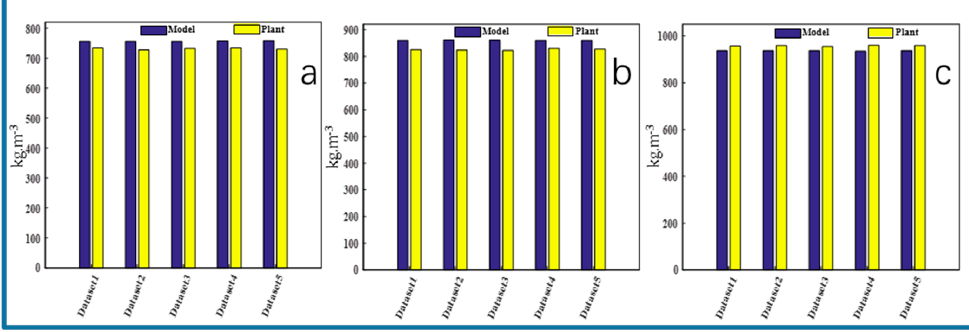
Figure 18. Predictions of the density of products: ( a ) naphtha; ( b ) diesel fuel; ( c ) tail oil.